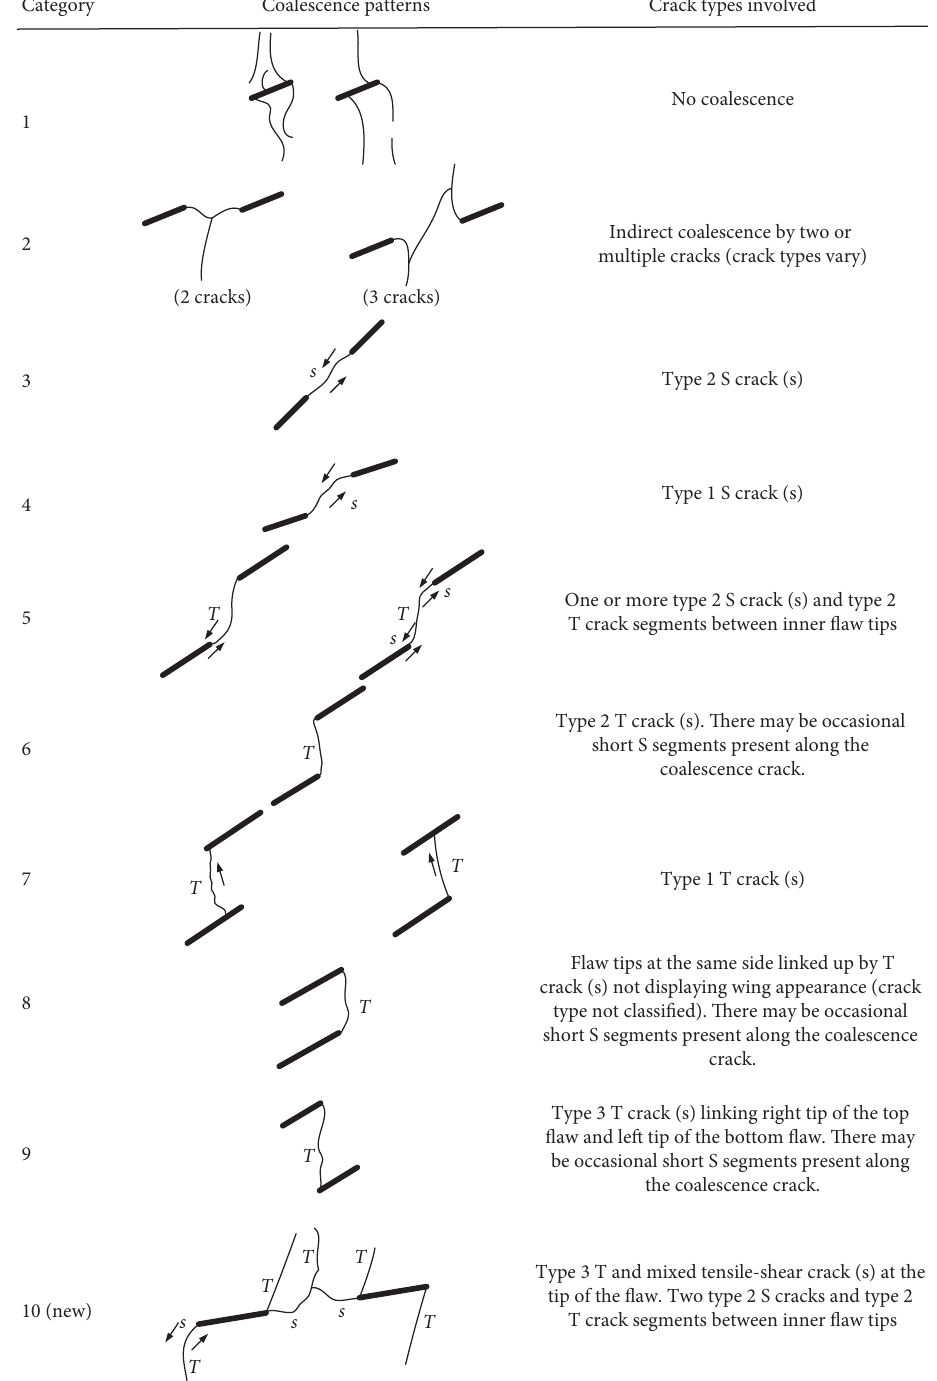
Figure 17: Ten crack coalescence categories obtained in the present